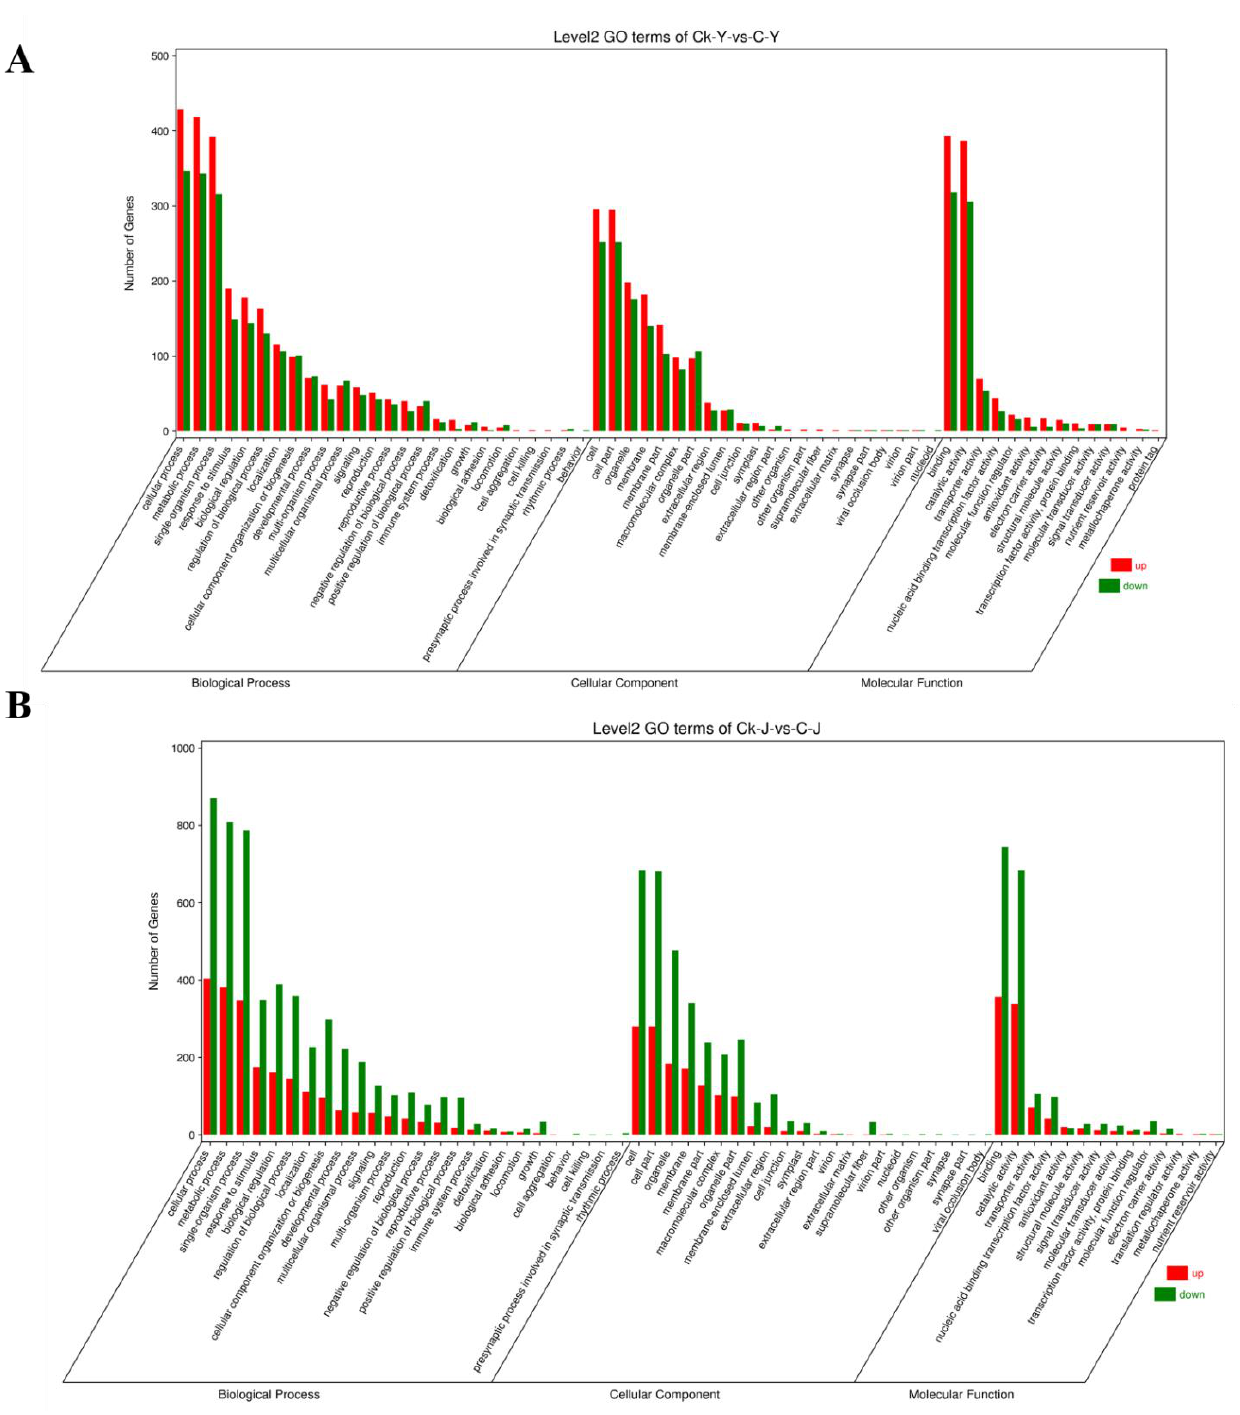
Figure 3. GO Annotation Analysis of the Differentially Expressed Genes (DEGs) between Treated and Control Samples. Two plots show distribution profiles of DEGs between control (CK-Y) and treated leaves (C-Y) ( A ) and between control (CK-J) and treated (C-Y) stems ( B ) in three functional categories. GO enrichment classification histogram: the abscissa is the secondary GO term, and the ordinate is the number of differential genes. Red color indicates upregulation and green color indicates downregulation. GO, Gene Ontology.